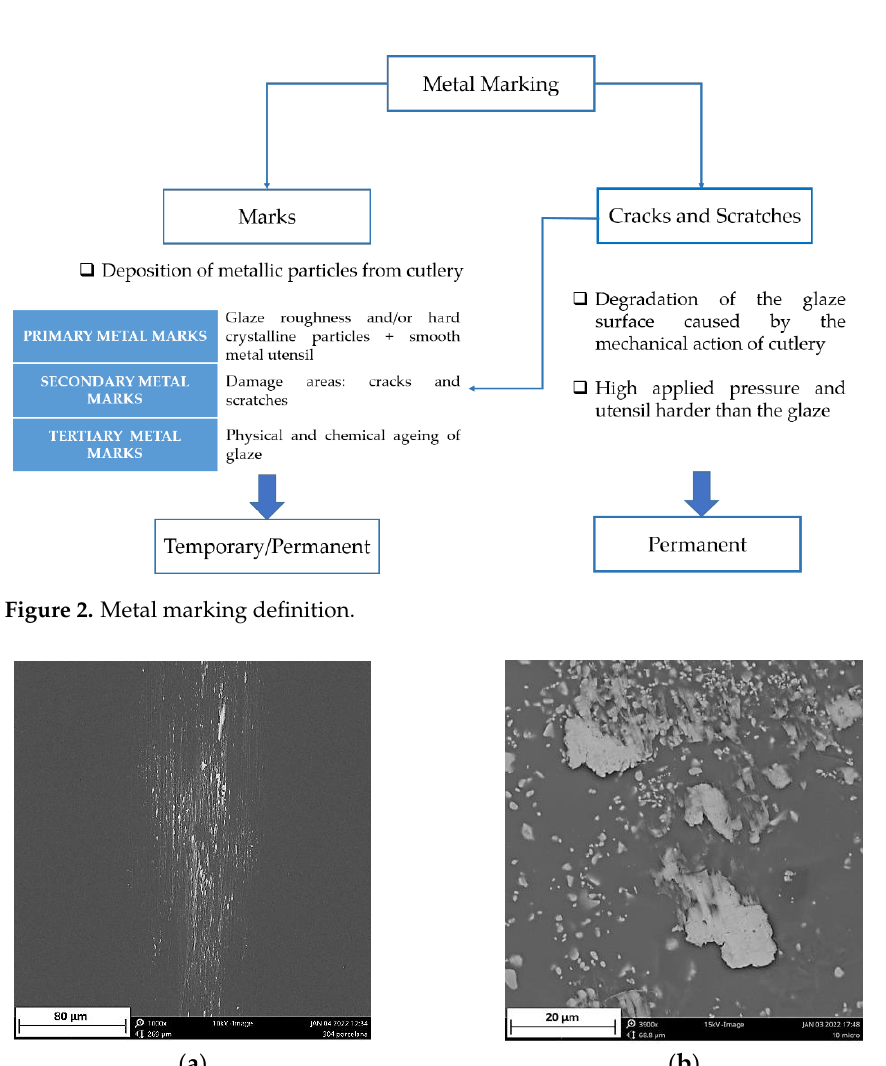
Figure 3. SEM micrographs of primary metal marking ( a ) metal marks from smooth utensil sliding over on porcelain hard glaze ( b ) metal tearing from protruding zircon particles present in opaque glaze.